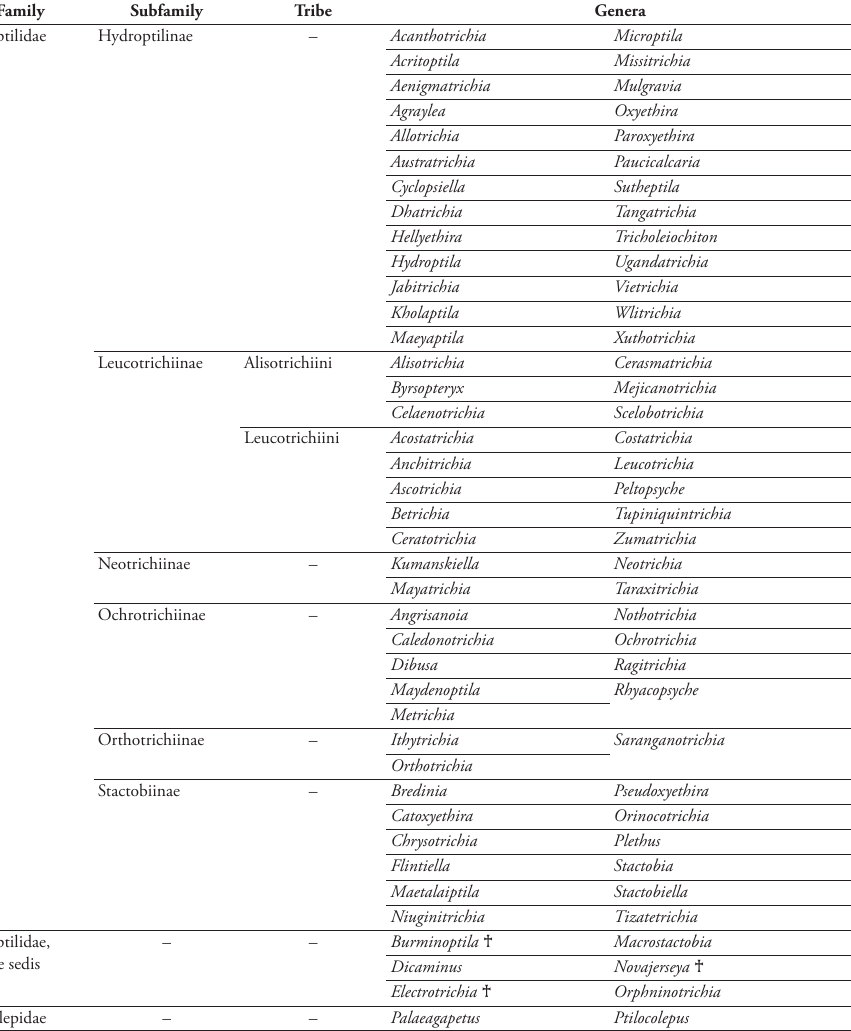
Table 1. Currently recognized genera of Hydroptilidae and Ptilocolepidae and family-group classification. Family Subfamily